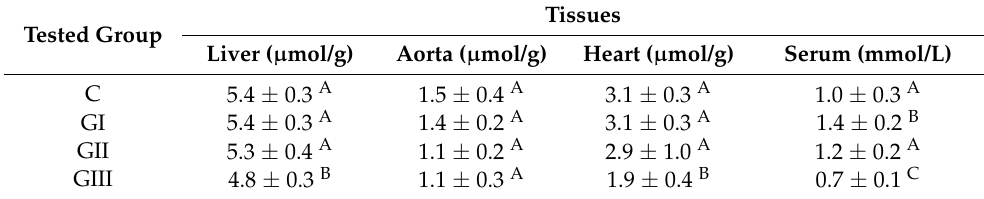
Table 6. Accumulation of triglycerides in